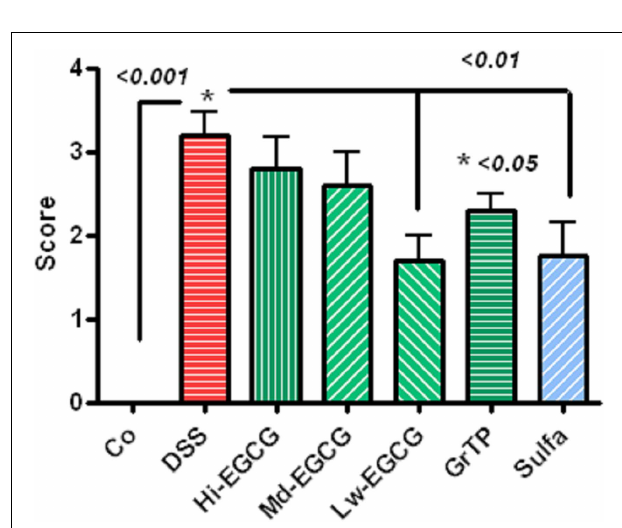
FIGURE 4 | Pathologic scores (zero-normal to four most severe) in colitic animals . DSS-induced severe colonic pathology. Low dose EGCG and sulfasalazine similarly attenuated pathological lesions ( p < 0.01).To a lesser extent, GrTP ( p < 0.05) ameliorated the colonic lesions.